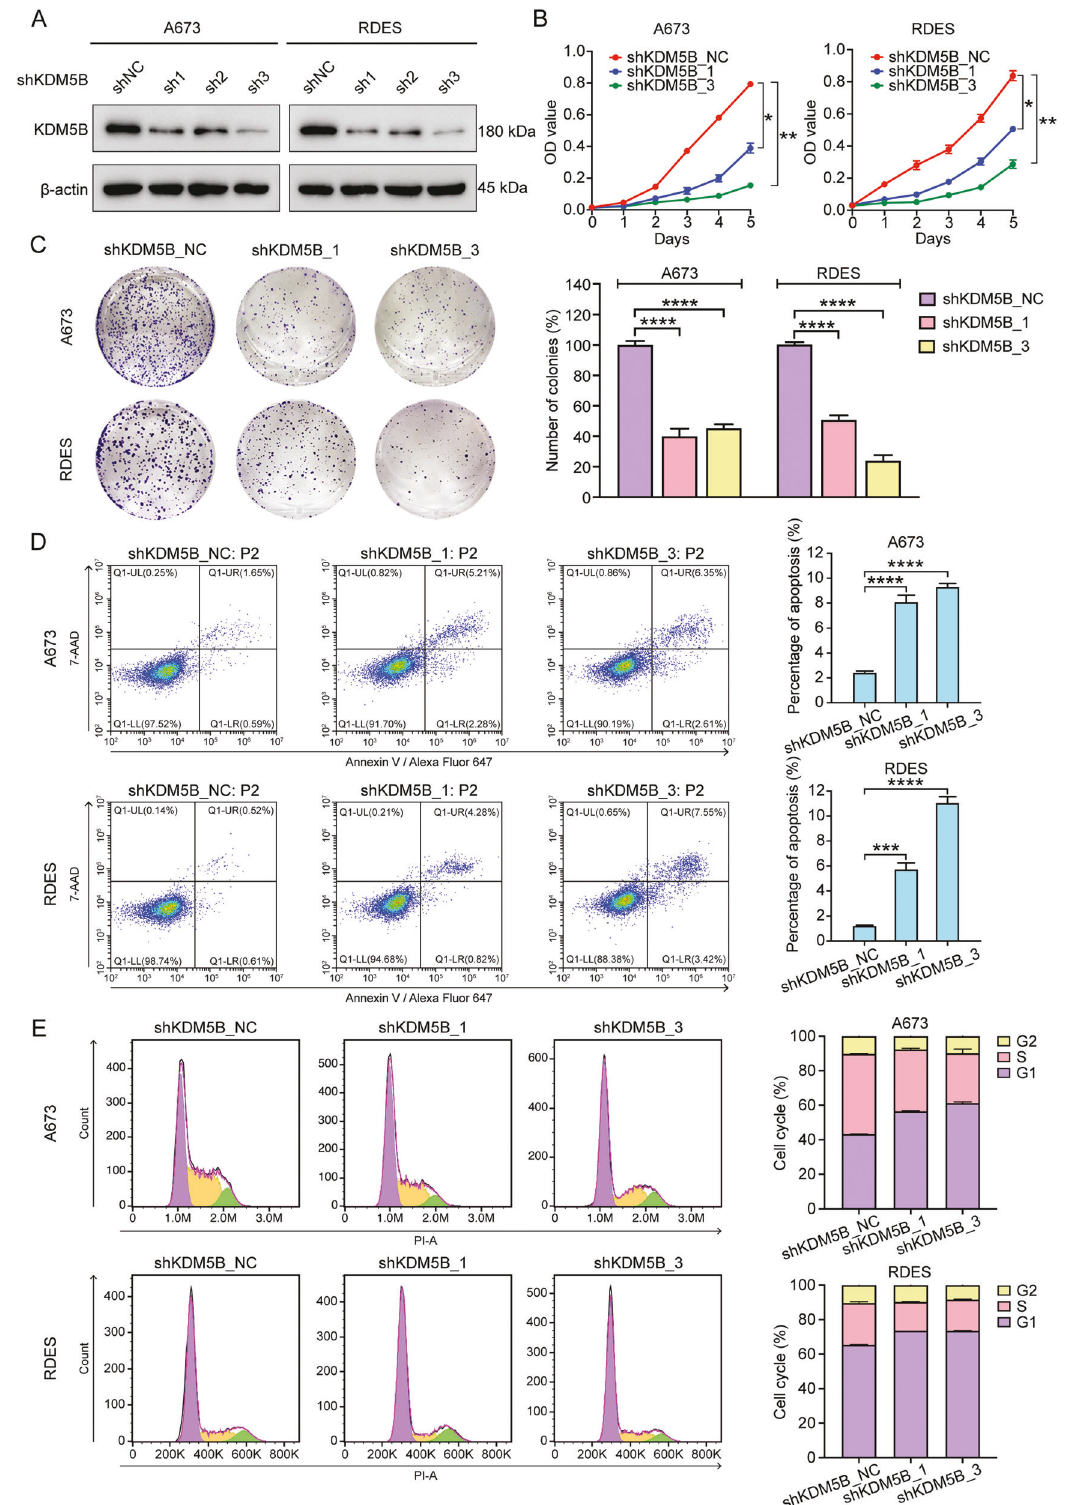
Statistical analysis was performed using GraphPad Prism software